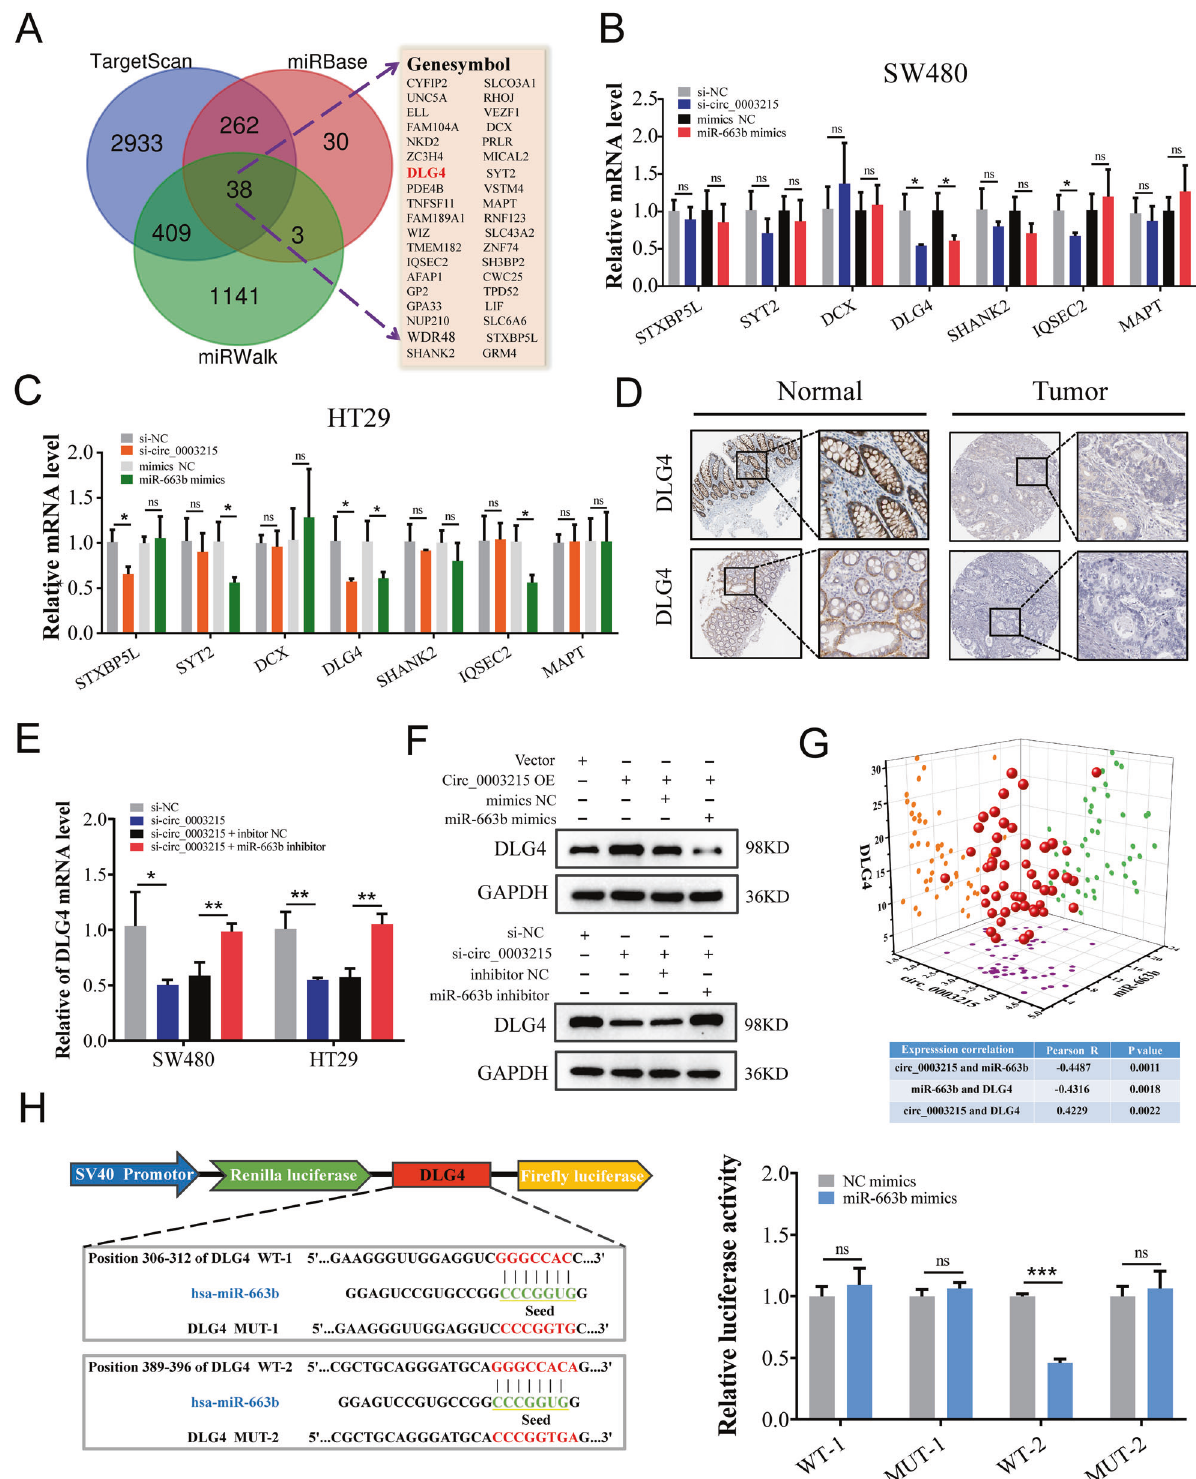
Fig. 6 DLG4 is a direct target of circ_0003215/miR-663b axis in CRC cells. A The intersection of the target genes of miR-663b predicted by miRBase, miRWalk, and TargetScan. B The expression of potential miR-663b target genes in SW480 cells transfected with miR-663b mimics or circ_0003215-speci fi c siRNA. C The expression of potential miR-663b target genes in HT29 cells transfected with miR-663b mimics or circ_0003215-speci fi c siRNA. D Immunohistochemistry showed the DLG4 protein levels in CRC tissues and normal colorectal mucosa from HPA database. E The expresssion level of DLG4 mRNA in SW480 and HT29 cells transfected with circ_0003215 siRNA or miR-663b inhibitors. F Western blotting of DLG4 was detected in SW480 cells after transfecting with indicated vectors. G Three-dimensional scatter plot of circ_0003215, miR-663b and DLG4 in 50 paired CRC and adjacent tissues. H Schematic representation of the DLG4 3 ’ -UTR WT and DLG4 3 ’ -UTR MUT luciferase reporter vectors(left). The relative luciferase activity in HEK-293T co-transfected with miR-663b mimics or NC and the DLG4 3 ’ - UTR WT or MUT reporter vectors (right). * P < 0.05, ** P < 0.01, *** P < 0.001. Cell Death and Disease